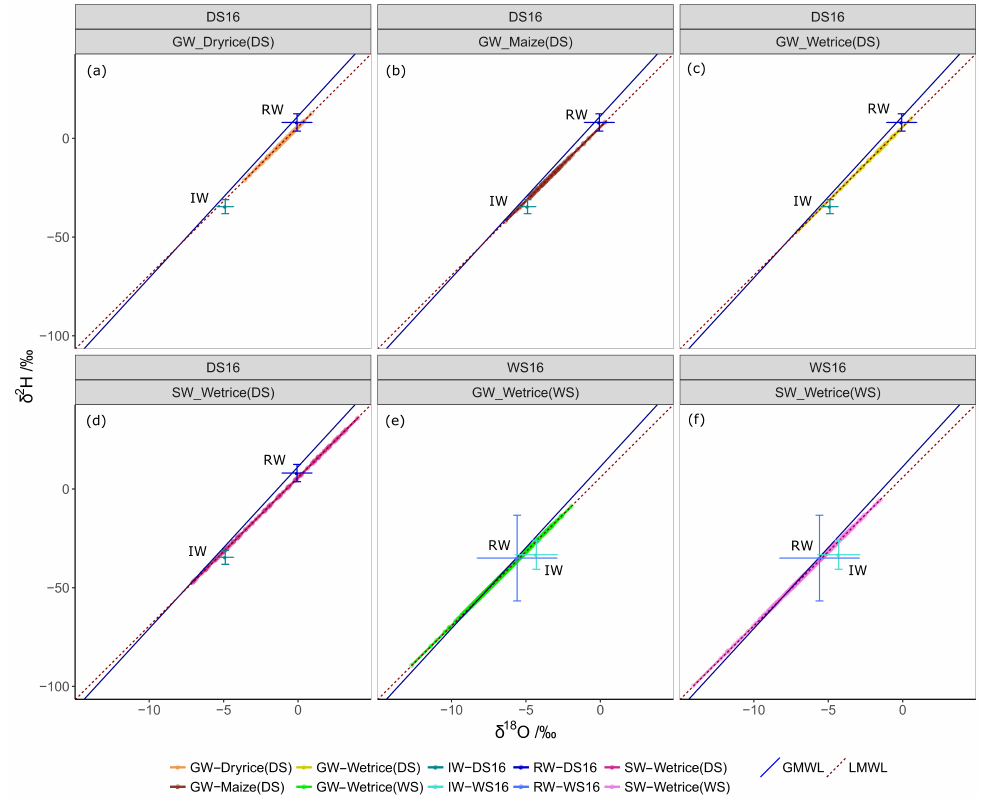
Figure 8. Projected isotope composition to prior evaporation of water sources: groundwater (GW) of dry rice ( a ), maize ( b ), wet rice ( c ), and surface water (SW) of wet rice ( d ) during the dry season (DS), and GW of wet rice ( e ) and SW of wet rice ( f ) during the wet season (WS), all of which were calculated using Equation (2). The mean isotope values for the water provenance (rainwater (RW) and irrigation water (IW)) are plotted with standard